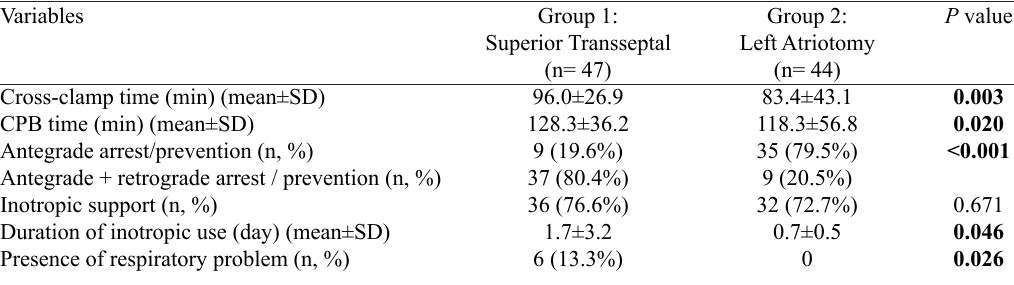
Table 2. A comparison of intraoperative variables between the groups.